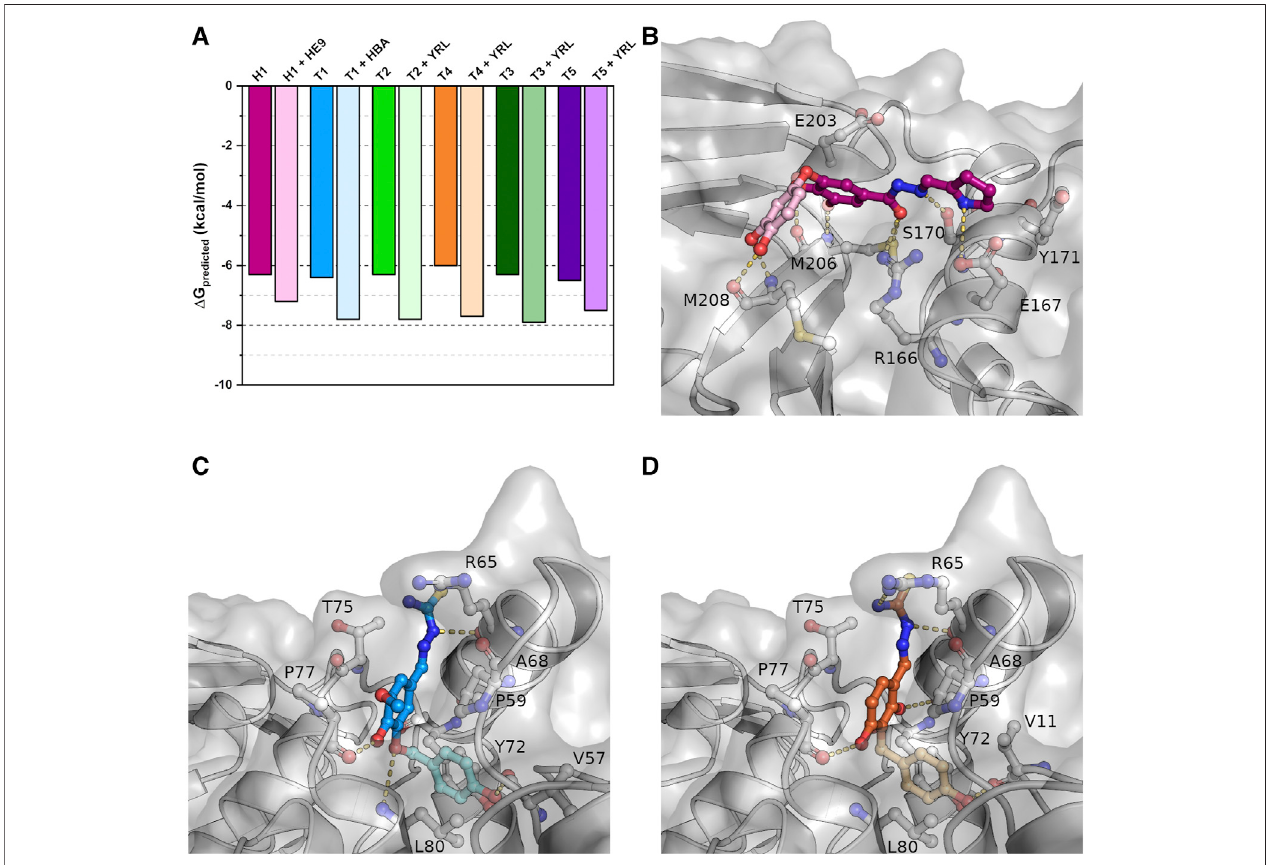
FIGURE 6 | Docking studies of extended compounds highlight potential of binders as lead compounds. (A) Results of the docking studies of crystallized and elongated binders. (B) The docked compound combining H1 (magenta) with HE9 (PDB: 7ofu, light pink) binding to the S1 site. (C) T1 (blue) combined with HBA (PDB: 7oft, light blue) binding to the S2 site. (D) T4 (orange) combined with YRL (PDB: 7ofs, light orange) binding to the S2 site. Shown are representative structures of the maximum cluster of the docked